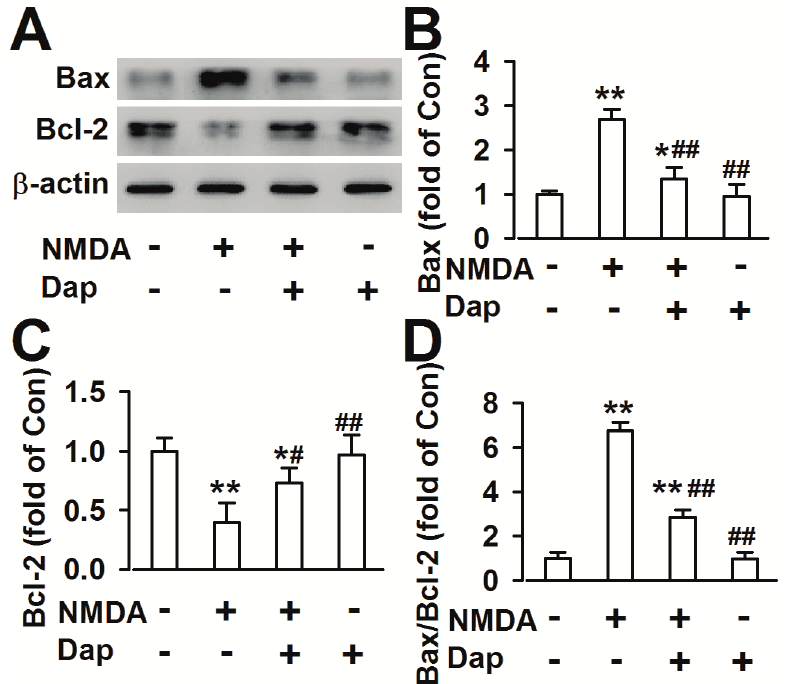
Figure 3. Effects of Dap on the levels of Bax and Bcl-2 ( A ) Expression levels of Bax and Bcl-2 proteins were detected by Western blot. ( B ) The result showed that the levels of Bax markedly increased after exposure to NMDA in cultured cortical neurons. Pretreatment of 10 μ M significantly decreased the levels of Bax. ( C ) The levels of Bcl-2 significantly decreased after exposure to NMDA in cultured cortical neurons. Pretreatment of 10 μ M Dap evidently increased the levels of Bcl-2. ( D ) The ratio of Bax/Bcl-2 was notably increased after NMDA exposure; however, the 10 μ M Dap reversed the ratio. The data were pooled from five independent experiments. * p < 0.05, ** p < 0.01 compared with control, # p < 0.05, ## p < 0.01 compared with NMDA